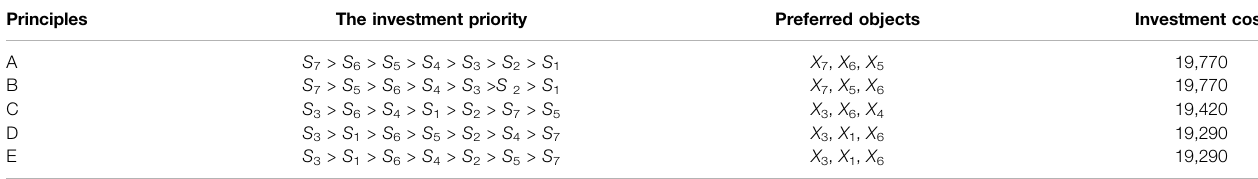
TABLE 4 | Optimization results under fi ve principles. Principles The investment